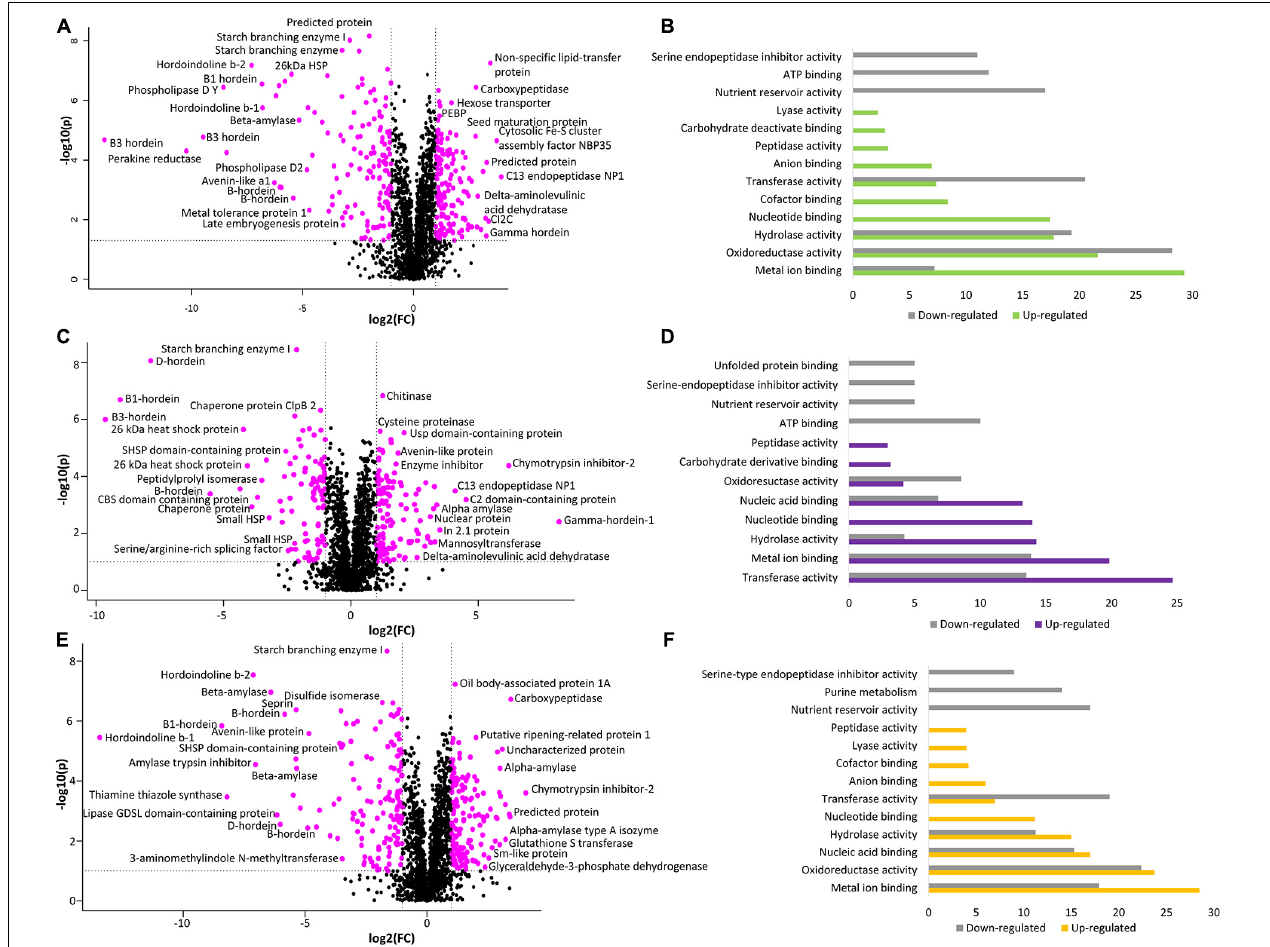
FIGURE 3 | The comparison between WT and double-mutant lines illustrates the alteration of protein abundances and their associated functional classes. (A) Volcano plot of fold-change vs. p-value for comparison of BC-mutant and WT lines. (B) GO analyses (molecular function) performed on perturbed proteins: increased (green) or decreased (grey) in the BC-mutant line relative to WT. (C) Volcano plot of fold-change vs. p-value for comparison of BD-mutant and WT lines. (D) GO analyses (molecular function) performed on perturbed proteins: increased (purple) or decreased (grey) in the BD-mutant line relative to WT. (E) Volcano plot of fold-change vs. p-value for comparison of CD-mutant and WT lines. (F) GO analyses (molecular function) performed on perturbed proteins: increased (orange) or decreased (grey) in the CD-mutant line relative to WT. The pink points in the volcano plots represent proteins with significant perturbation ( p < 0.05; FC < 0.5 or FC >